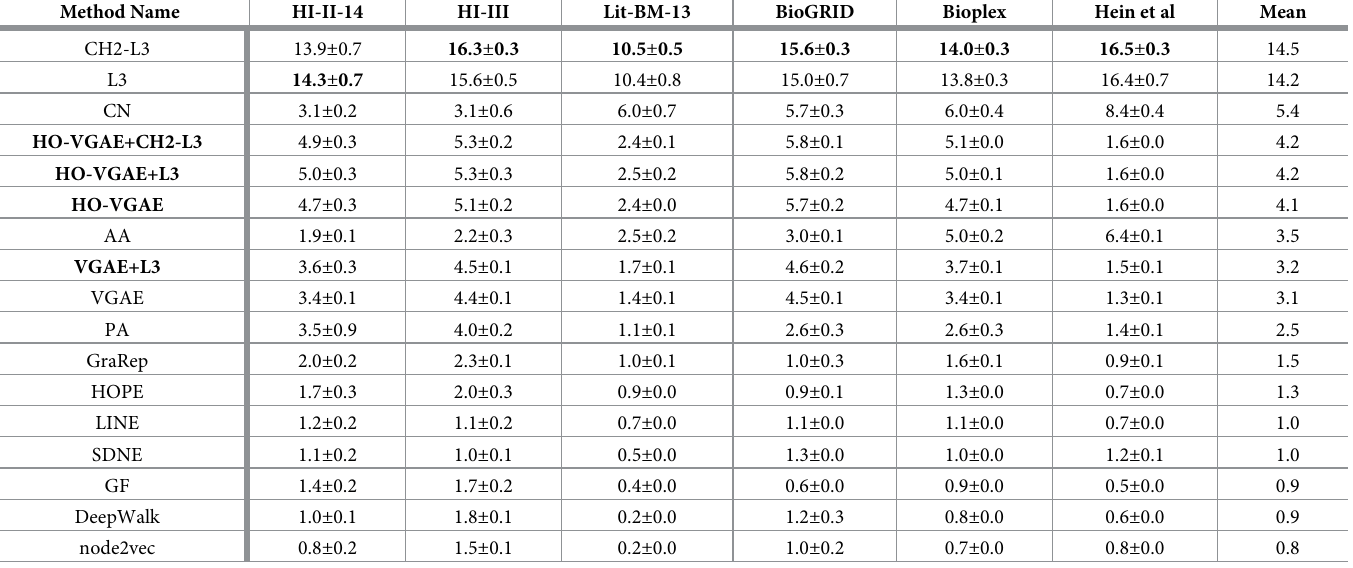
Table 1. Link prediction performance on six human PPI networks (AUPR). All unknown pairs were treated as negative examples. Method